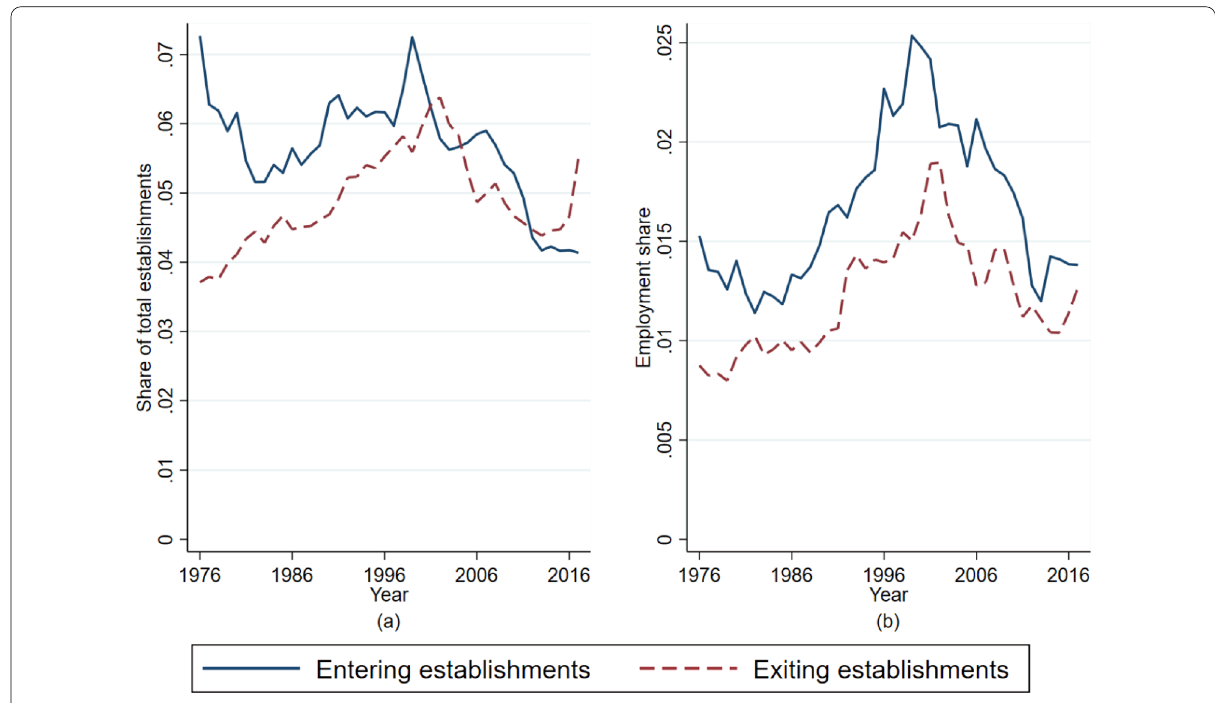
Fig. 1 Evolution of business entries and exits over time in West